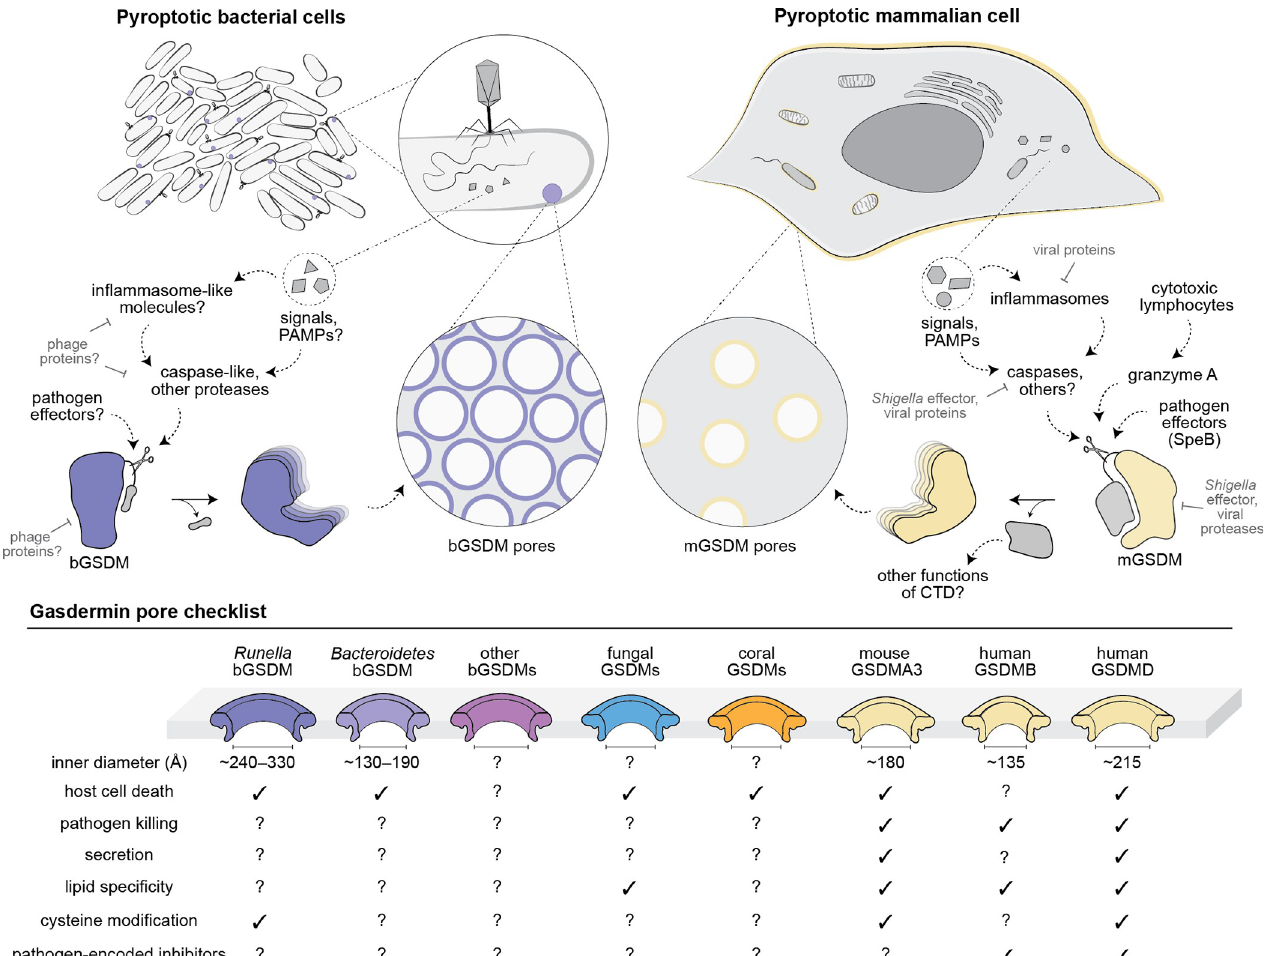
Fig 1. Pyroptosis across the tree of life. The top model depicts pyroptotic bacterial and mammalian cells with shared and unique signaling pathways. In this case, bacterial pyroptosis is induced by phage infection and unknown PAMPs or other signals that trigger bGSDM activation. Mammalian pyroptosis is induced by intracellular bacteria (and viral infection; not shown), leading to mGSDM activation through PAMPs or other signals, and pore formation on the plasma membrane, bacterial membranes, and mitochondria. Examples of known and predicted pathogen-encoded inhibitors are indicated with flat arrowheads. The bottom checklist depicts relative sizes of gasdermin pores across the tree of life and select features. The bacterial species are abbreviated to Runella ( Runella zeae IMG ID 2525253496) and Bacteroidetes (unclassified Bacteroidetes metagenomic isolate IMG ID 2806880301). bGSDM AU : AnabbreviationlisthasbeencompiledforthoseusedinFig 1 : Pleaseverifythatallentriesarecorrect : , bacterial gasdermin; CTD, C-terminal domain; mGSDM, mammalian gasdermin; PAMP, pathogen-associated molecular pattern.